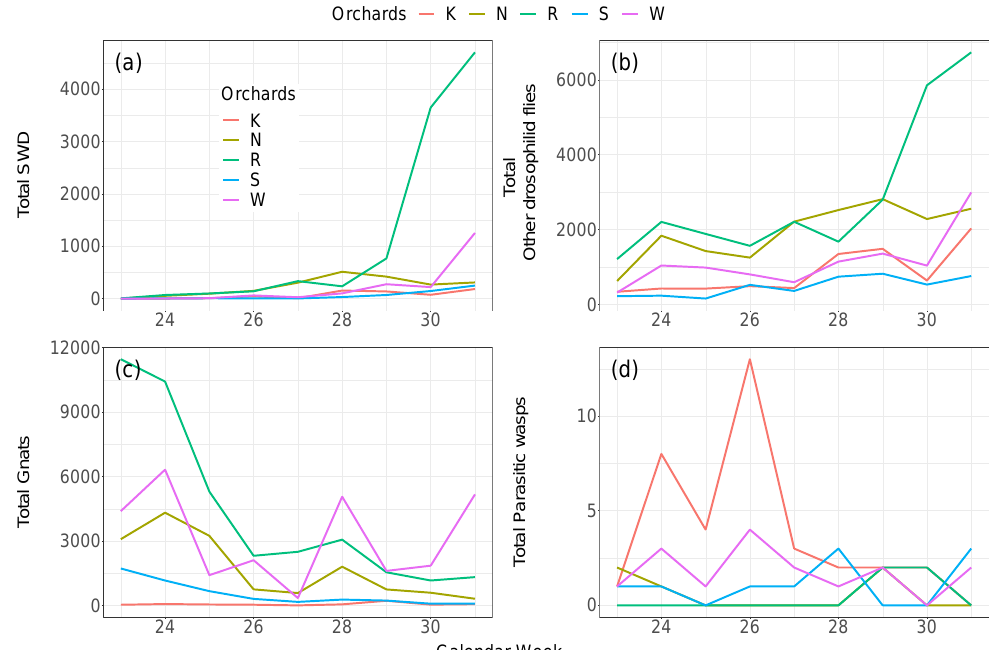
Figure 2. Number of SWD ( a ); other drosophilid flies ( b ); gnats ( c ); and parasitic wasps ( d ) from 23rd to 31st calendar week at the five orchards. Note the different dimensions of the y